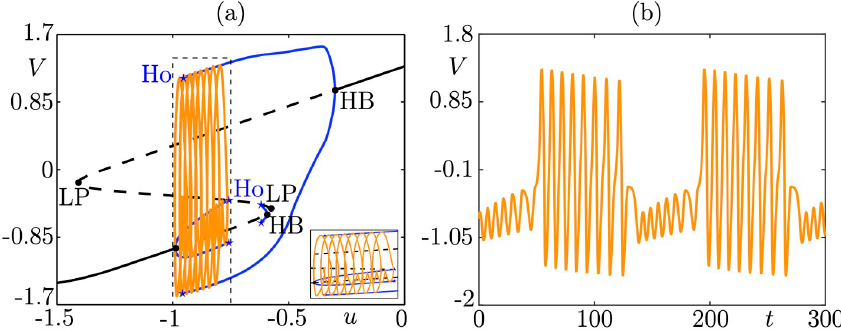
Fig 5. Small homoclinic/big homoclinic bursting, corresponding to Fig 88 of [7]; shown is a new simulation with the same parameter values (available in [7]). Panel (a) shows the slow-fast dissection in the ( u , V ) phase plane; the inset shows a zoom corresponding to the dashed rectangle, which better reveals the shape of the bursting cycle while the main plot better highlights the fast subsystem bifurcation structure. Labels HB, LP, and Ho refer to Hopf bifurcation, saddle-node bifurcation (fold or “limit point”), and homoclinic bifurcation of the fast subsystem, respectively. Panel (b) shows the V -time series of this bursting solution. Izhikevich’s classification allowed to characterize bursting patterns beyond square-wave, elliptic and parabolic, and already opened the door toward explaining more complex biological data. In particular, one can mention pathological brain activity related to, e.g., epileptic seizure [52] or spreading depolarization [16,53]. According to Izhikevich’s classification, bursting oscillations where the burst initiates via a fold bifurcation of the fast subsystem are termed fold-initiated bursting . In the present work, we will propose an extended classification based upon fold-initiated bursting